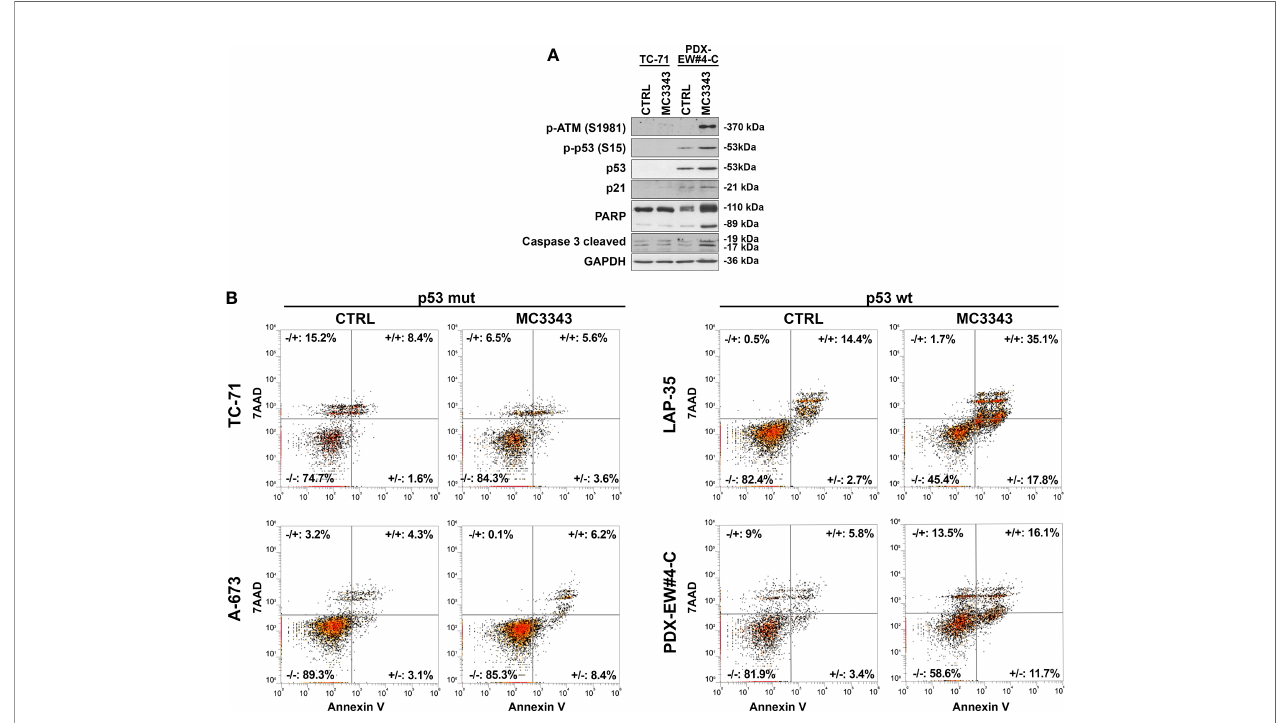
FIGURE 5 | Activation of p53 signaling and induction of apoptosis in TP53 wild type cell lines. (A) TP53 mutated TC-71 cell line and TP53 wild-type PDX-EW#4-C cells were treated with 3µM MC3343 for 24h. Whole cell lysates were analyzed using western blot. Three independent experiments were performed and one representative immunoblot of p-ATM, p21, phospho-p53, p53, PARP and caspase-3 cleaved is shown (B) Representative fl ow cytometry scatter plots showing apoptosis of p53 mutated (TC-71 and A-673) and p53 wild-type (LAP-35 and PDX-EW#4-C) EWS cells stained with Annexin-V/7-AAD following 48h treatment with MC3343 (3-5 µM) or DMSO. Numbers at the corners represent the percentage of cells found in each quadrant (viable-lower left, early apoptotic-lower right, late apoptotic-upper right, and dead cells-upper left are